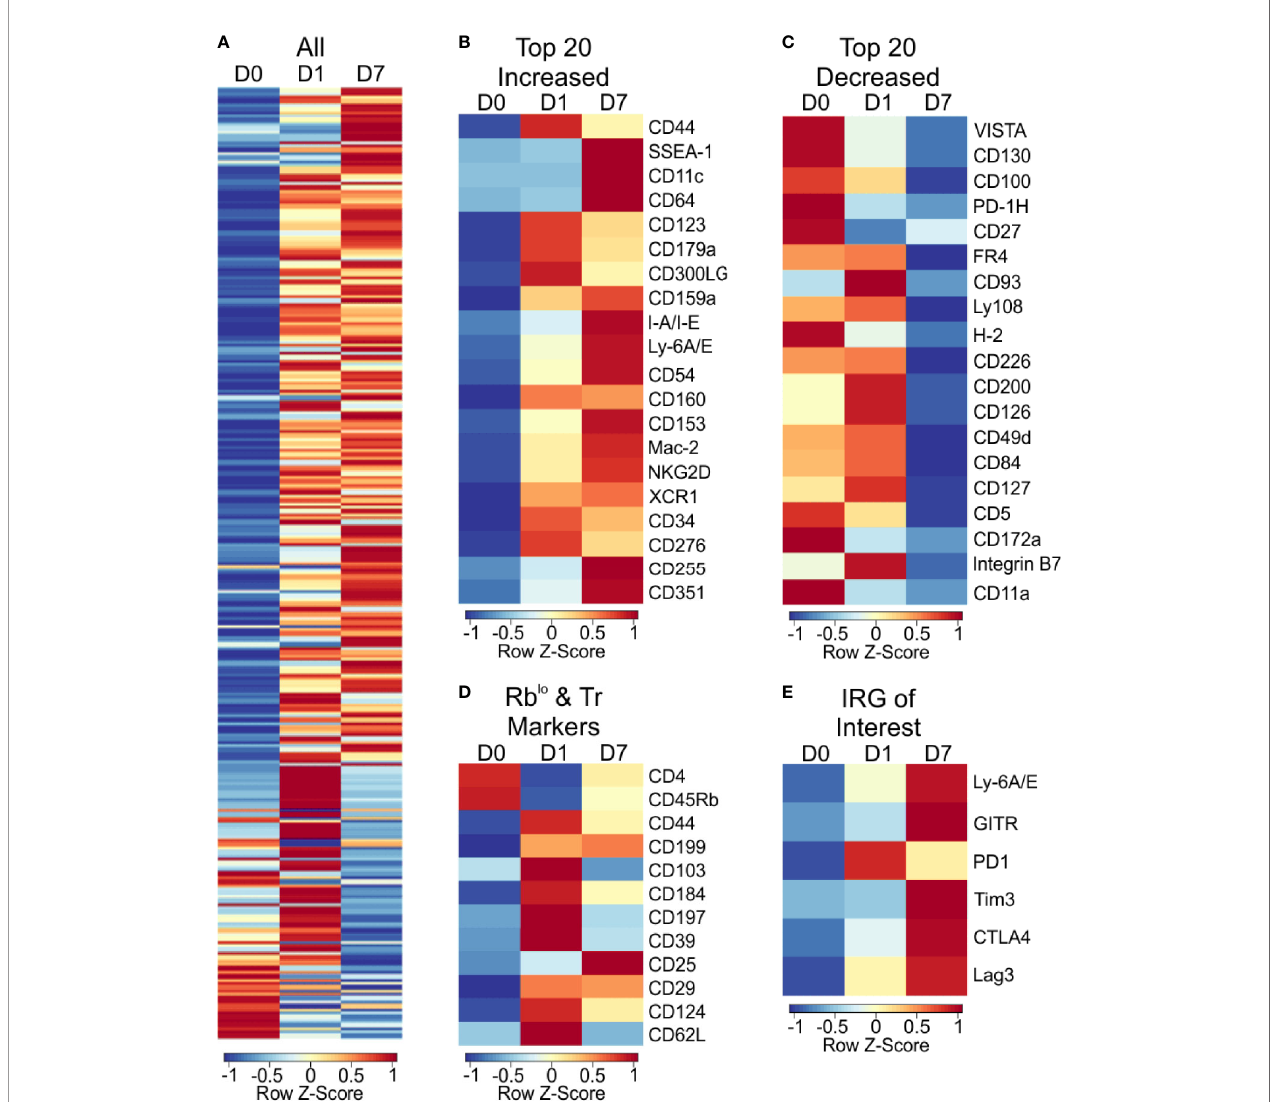
FIGURE 5 | Cell surface marker expression of PSA exposed CD4+ T cells identi fi es immunomodulatory markers. High throughput fl ow cytometry was used to obtain the cell surface marker expression of 255 markers using LegendScreen Mouse PE kit. APC and T cells were co-cultured with PSA and collected at D0, D1, and D7. Data shown is geometric MFI from CD4 + T cells. Data is row z-scores. (A) Summary heat map of all 255 markers on D0, D1 and D7. (B) Top 20 markers most increased and (C) decreased on D7 compared to D0. (D) Markers previously used to identify PSA responsive T cells in human and murine experiments. (E) Activation and immunomodulatory markers upregulated with PSA